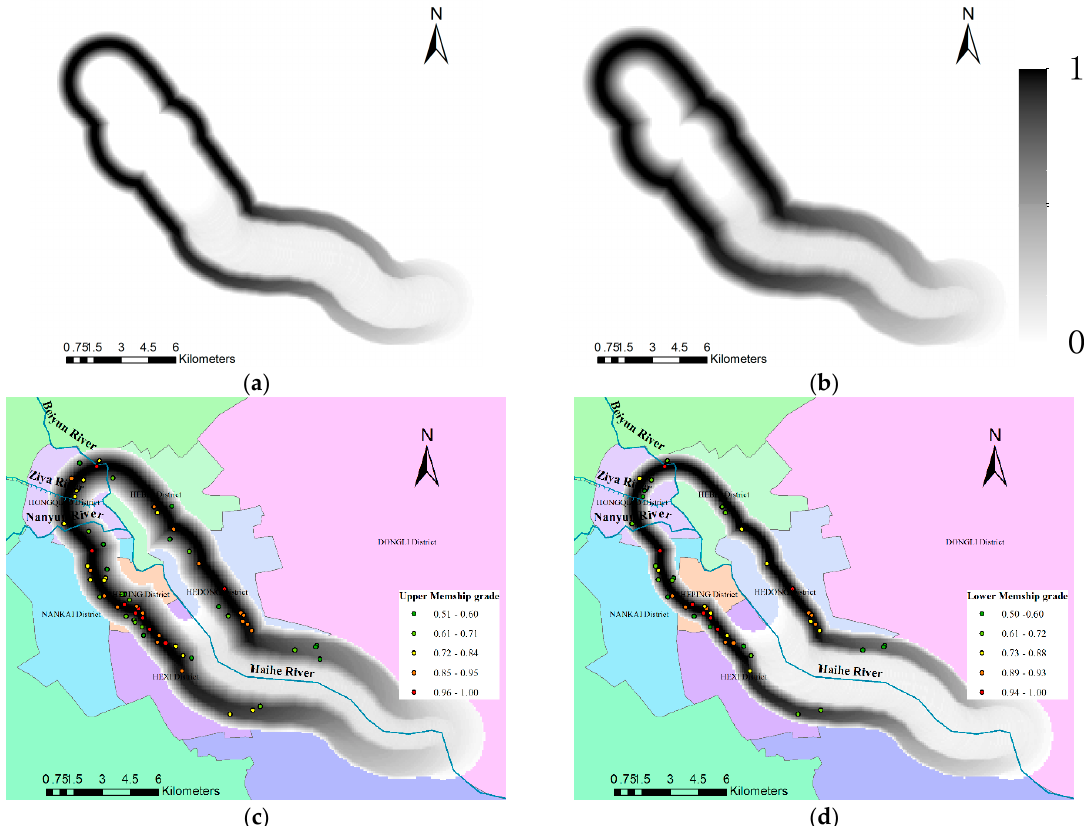
Figure 10. The region with “medium” distance to the Haihe River by bicycle and the primary schools located in this region. ( a ) Lower membership grade of “medium” region; ( b ) upper membership grade of “medium” region; ( c ) the primary schools located in the “medium” region with upper membership grade greater than 0.5; ( d ) the primary schools located in the “medium” region with lower membership grade greater than 0.5. Table 3. The primary schools located in the “medium” distance to the upstream of the Haihe River which is modeled as IT2 FS.